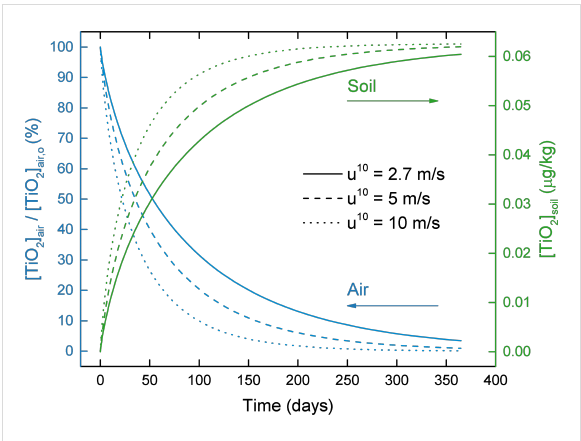
Figure 10: Effect of dry deposition on the reduction of TiO 2 concentra- tions in air and soil (postcessation of all ENM releases) in Los Angeles as a function of wind speed (range of 2.7–10 m s − 1 ). Regional geographical parameters are reported in Supporting Information File 1,